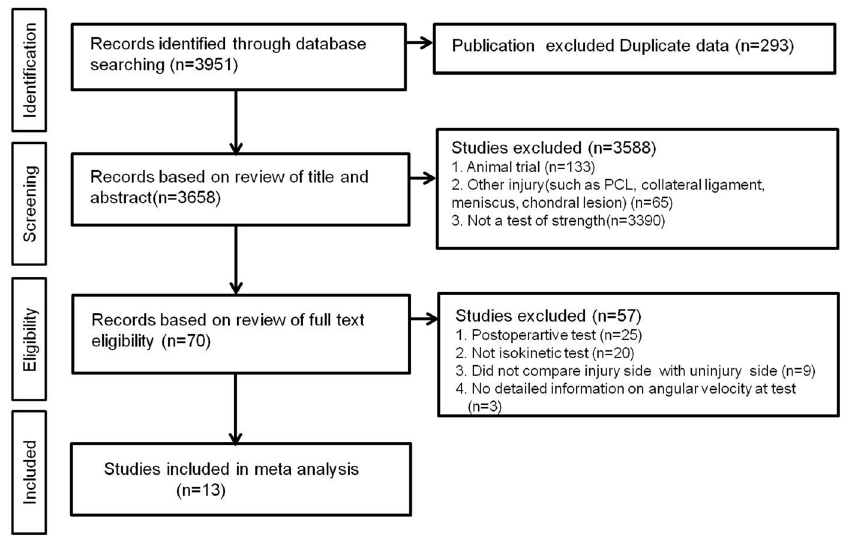
Fig 1. PRISMA (Preferred Reporting Items for Systematic reviews and Meta-analyses) flow diagram of the identification and selection of the studies included in this meta-analysis.